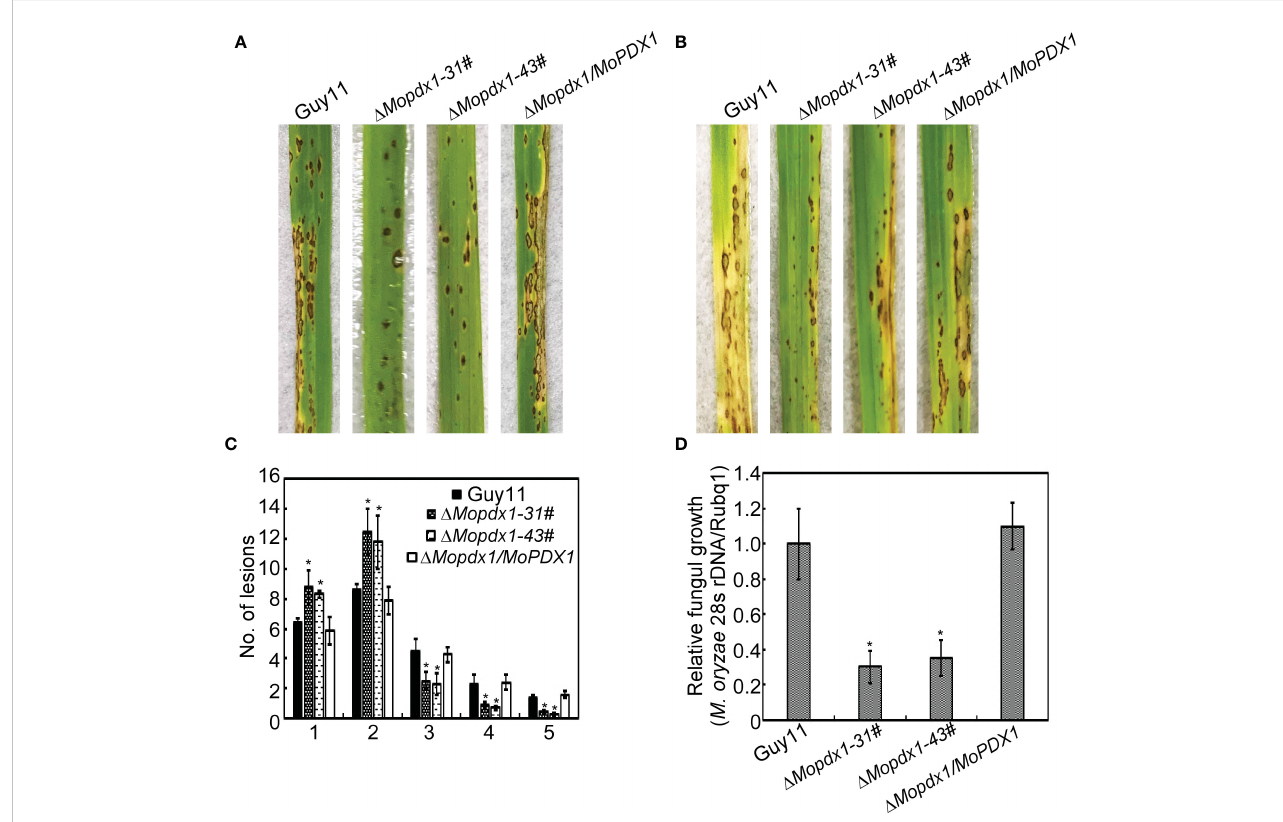
FIGURE 4 MoPdx1 regulates the pathogenicity of M. oryzae . (A) Five milliliters of conidial suspensions (5×10 4 spores/mL) of the indicated strains were severally sprayed onto 11-d rice CO-39 seedlings in a moist chamber with 90% relative humidity at 28°C. The diseased leaves were photographed at 7 dpi. (B) Conidial suspensions (15×10 4 spores/mL) were injected into 21-d rice sheath cells. Photographs were taken at 5 dpi. (C) Lesion-type statistical analysis at 7 dpi. Lesion-type classi fi cations were as referred to Yang et al., 2019. Error bars represent the standard deviation. Asterisks represent signi fi cant differences (LSD and Student-Newman-Keuls test, p <0.05). (D) Relative fungal content analysis in leaves of equal area by quanti fi cation of M. oryzae 28S rDNA relative to rice Rubq1. Error bars represent the standard deviation. Asterisks represent signi fi cant differences (LSD and Student- Newman-Keuls test, p